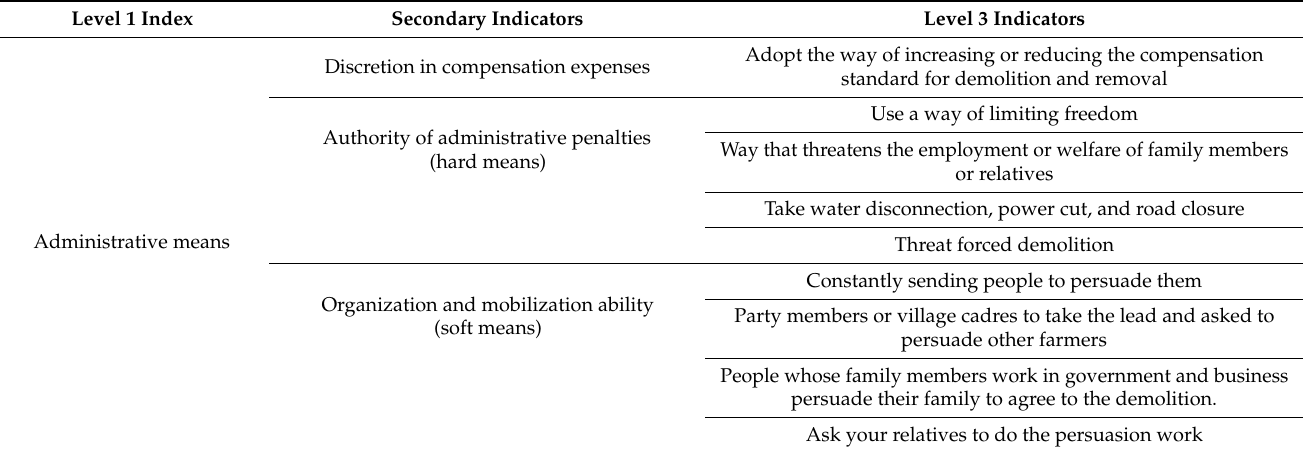
Table 1. Index setting of administrative means.